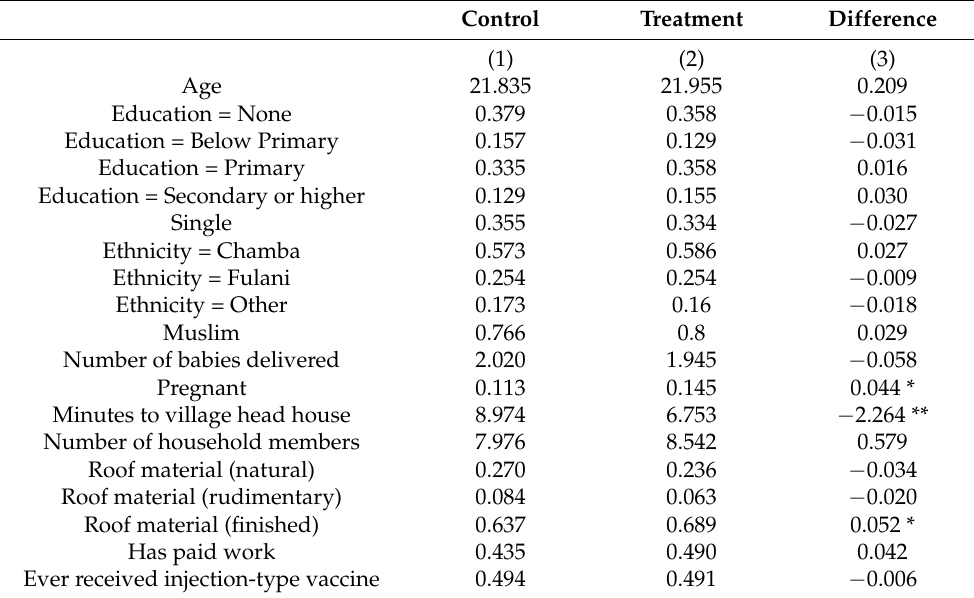
Table 2. Baseline